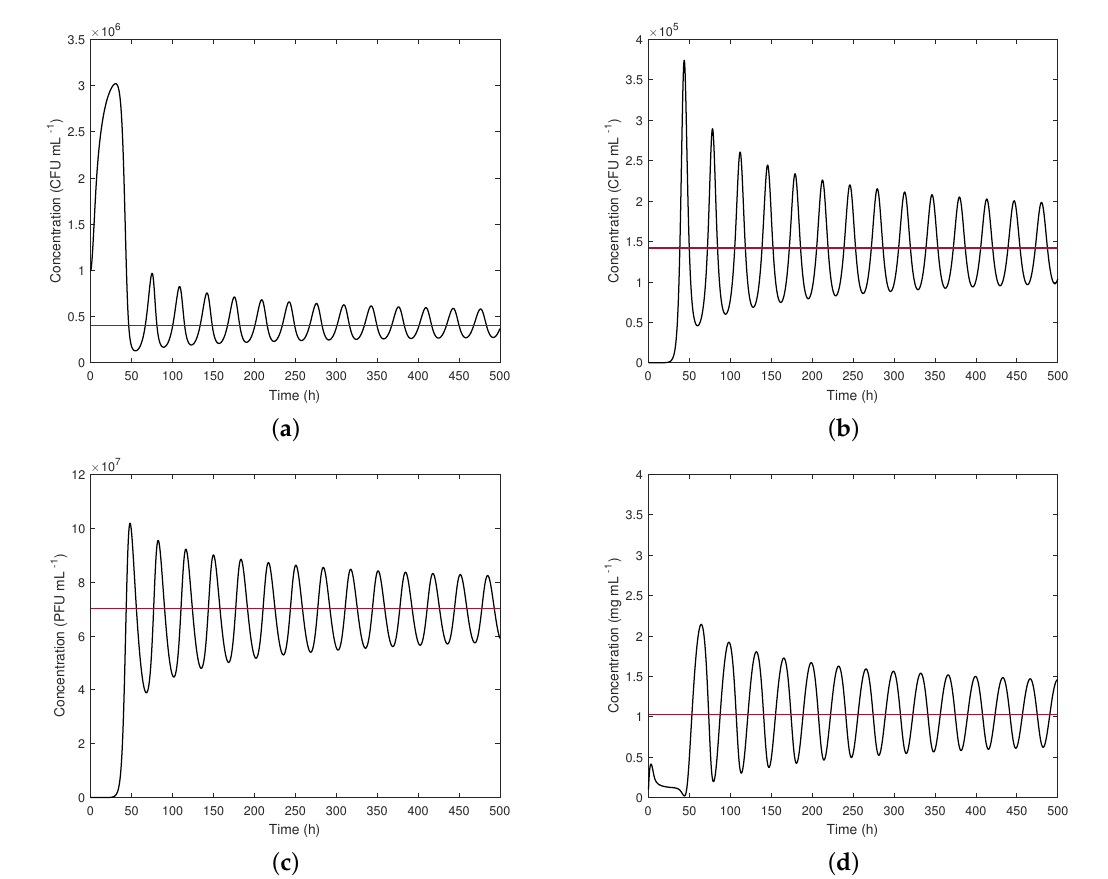
Figure 4. Time evolution. ( a ) Susceptible bacteria. ( b ) Infected bacteria. ( c ) Phages. ( d ) Substrate. Initial conditions X S 0 = 1 × 10 6 CFU mL − 1 , X I 0 = 0, P 0 = 1 × 10 2 PFU mL − 1 and S 0 = 0.1 mg mL − 1 . Dilution rate: D = 0.1 h − 1